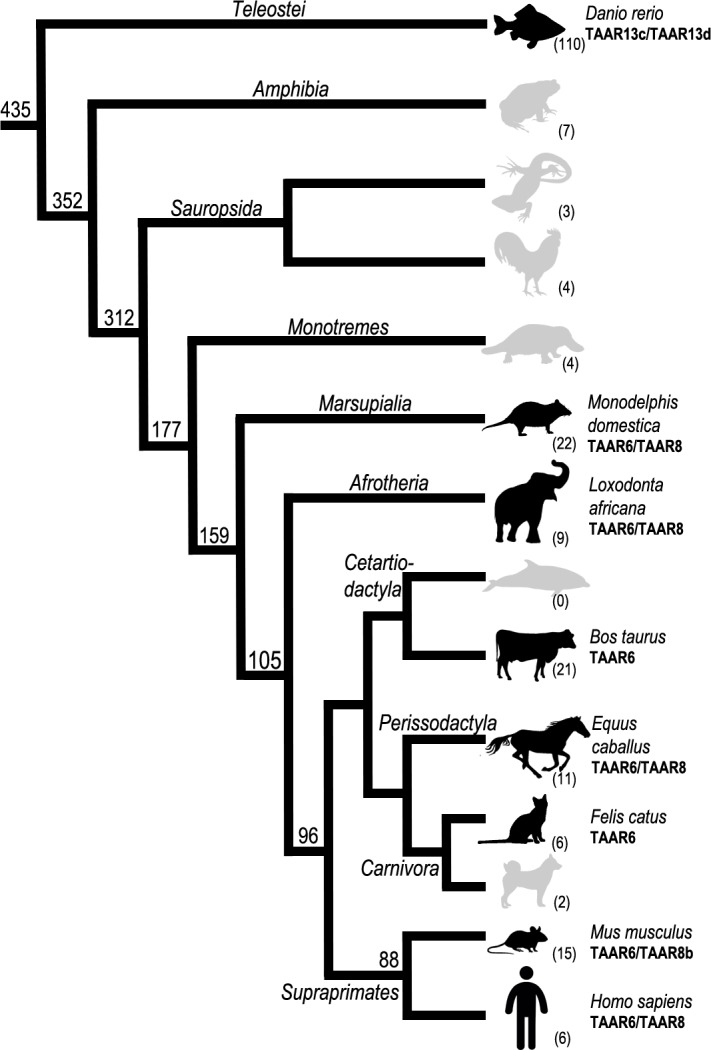
Cladogram representing the presence of TAARs in a consensus phylogeny of different vertebrates.The total number of functional TAAR genes is shown in parenthesis for each organism. Teleost TAAR13c/TAAR13d with proven affinity for CAD/PUT, respectively and therian-specific TAAR6/TAAR8 with the conserved tandem of aspartates in the TM3 and TM5 appear in bold (corresponding to black silhouettes in the species of origin). Approximate divergence times between species (million years ago; MYA) are shown in the internal nodes.